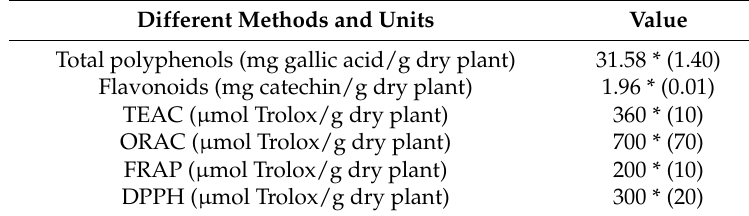
Table 1. Total polyphenol content and antioxidant activity assessed by the ORAC (oxygen